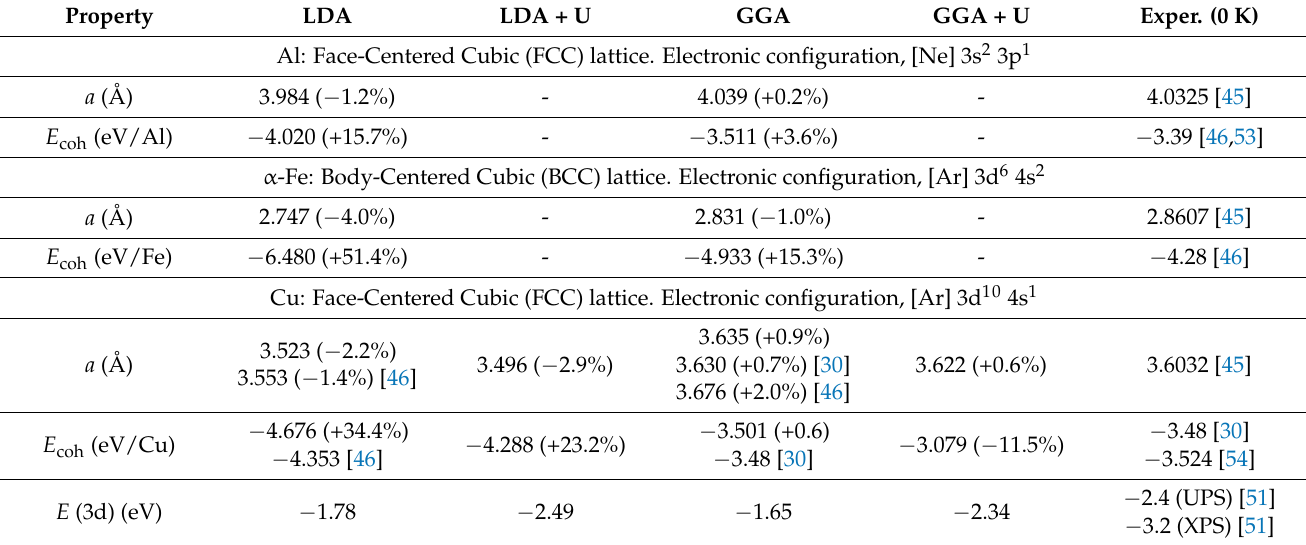
Table 1. Calculated cohesive properties (lattice parameter, cohesive energy) for elemental solids Al, Fe, and Cu using both DFT and DFT+ U methods (U = 4 eV) with comparison with available experimental values and previous calculations in the